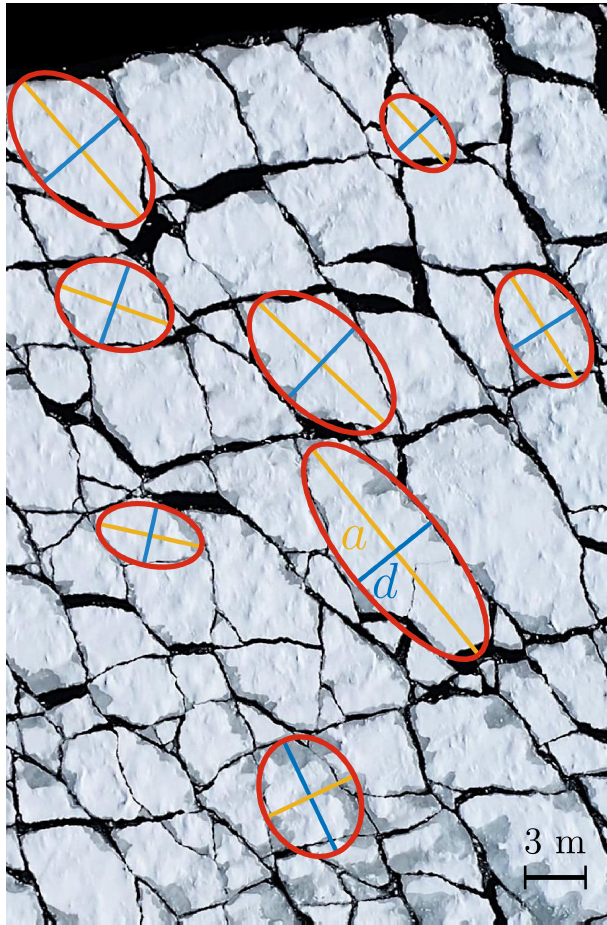
Figure 4. Sample of the ellipses fitted on the ice floes by MATLAB. Yellow and blue lines indicate the major and minor axes of length a and d ,